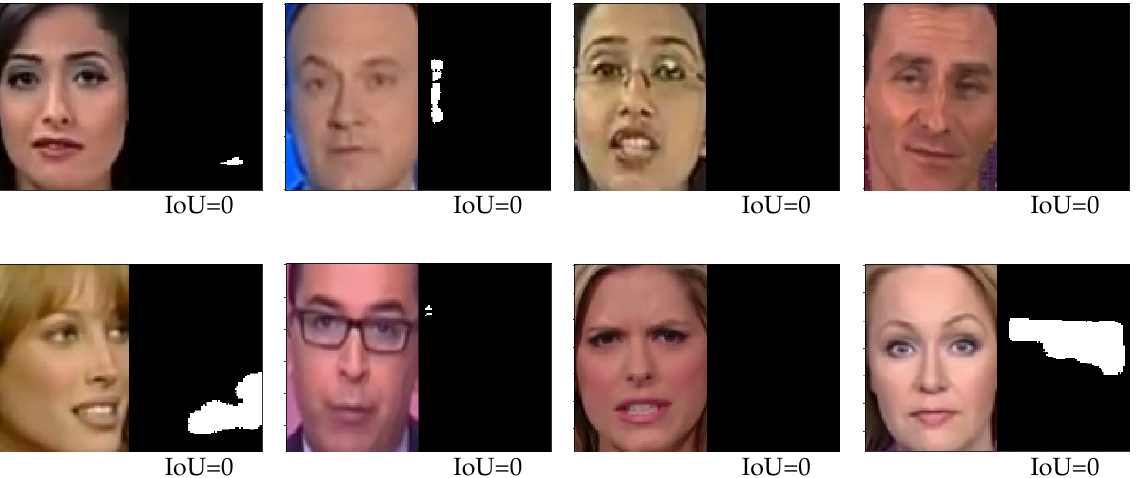
Figure 7. Randomly selected images from detecting real images by the model trained with the Deepfakes dataset. The left side of every pair of sub-images is the real image and the right side of every pair of sub-images is the prediction